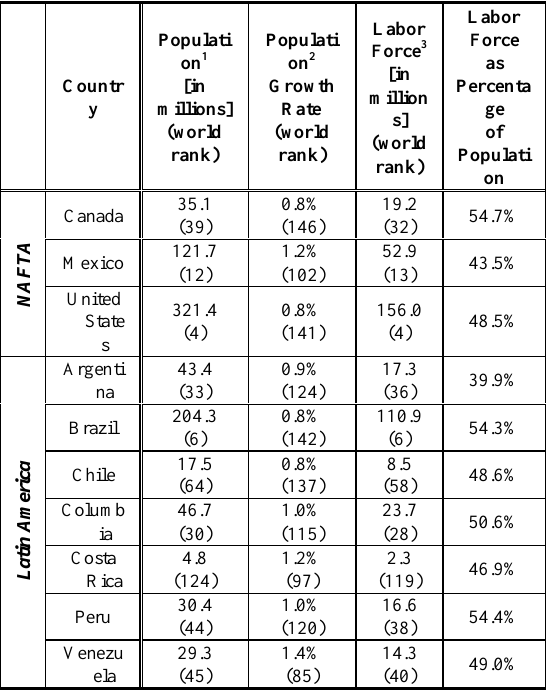
Table 1: Population, Growth Rate and Labor Force by